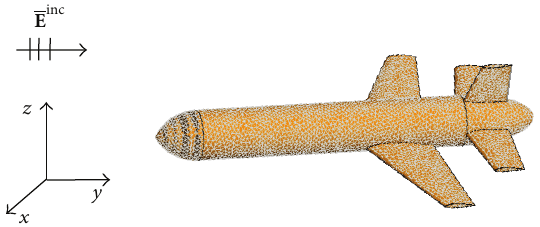
Figure 5: LHM coated PEC missile